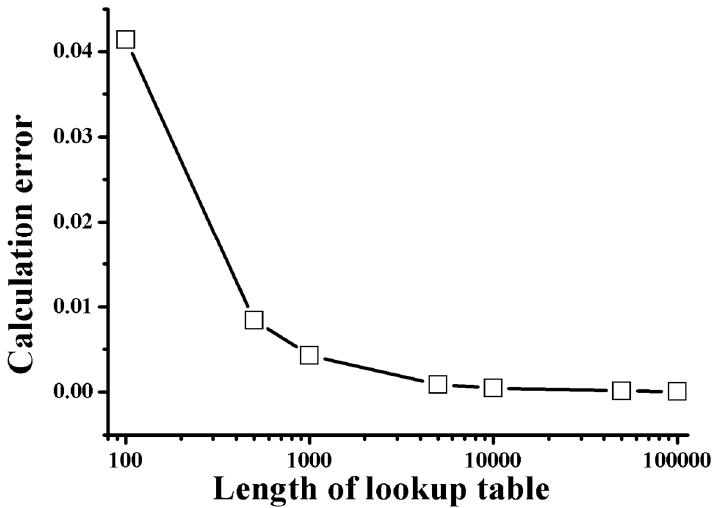
Figure 3. Calculation error as the function of the table length, the error was calculated by subtracting the lookup table calculation from the actual logarithmic value.